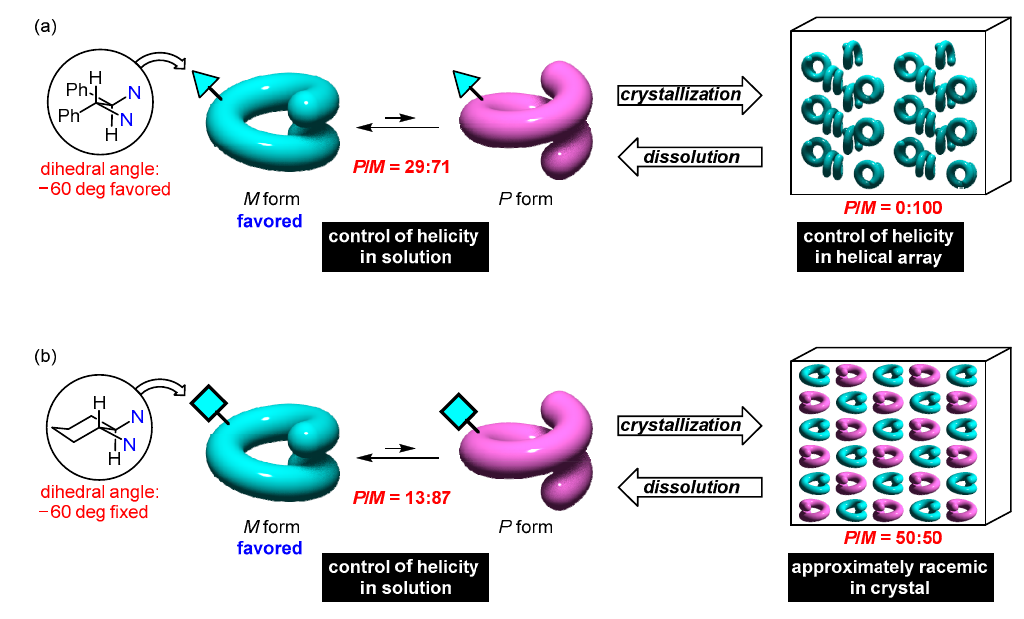
Figure 16. The P / M ratios of ( a ) L 5 Zn 3 La and ( b ) L 6 Zn 3 La in solution and in the crystal.